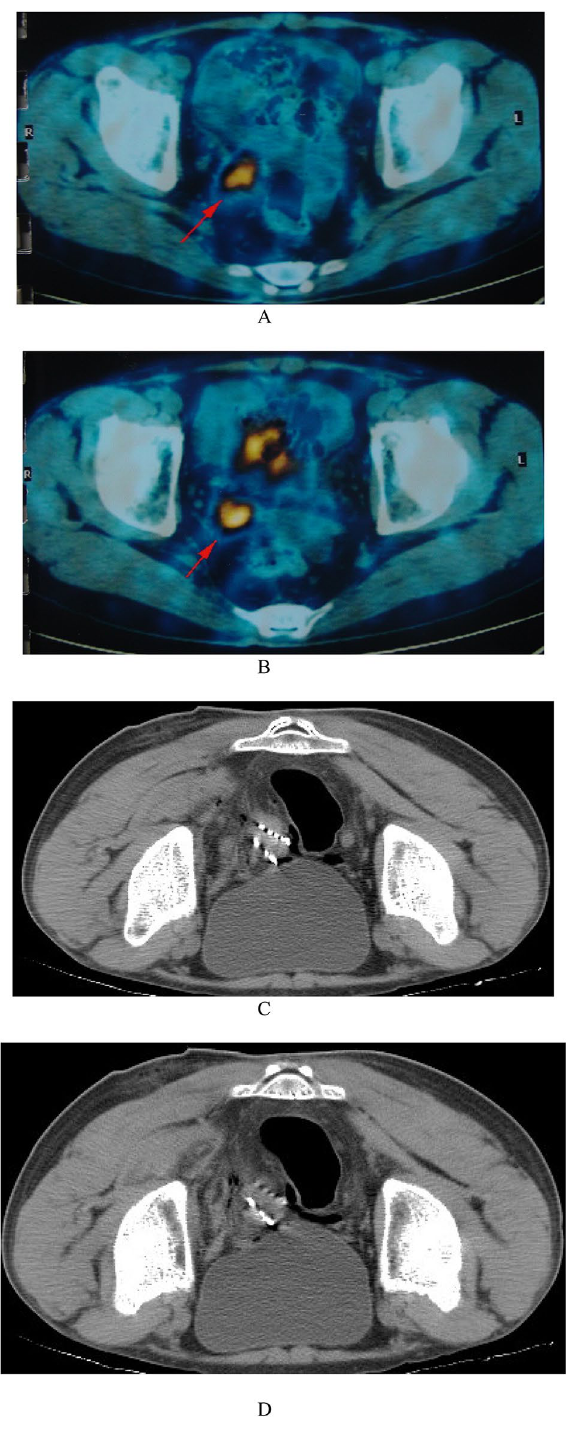
Figure 1. A 35-year-old patient with a tumor of pelvic recurrence after cervical cancer surgery. Tumor dimensions: 20 mm × 2.5 mm × 3.0 mm before treatment. ( A , B) The imaging of PET-CT before multimodality minimally invasive treatment showed abnormal radioactivity concentration in the pelvic. ( C , D ) The imaging of CT after the 125I implantation